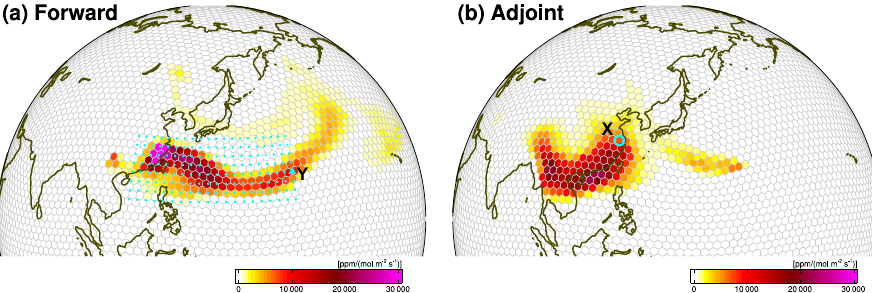
Figure 5. The concentration field at 3km altitude on 00:00UTC 8 January 2010 simulated by the forward model (with the flux limiter) from the basis unit flux X (a) and the sensitivities of the observation Y against the surface fluxes (footprint) simulated by the continuous adjoint model (b) . The observation points, from which the adjoint sensitivities are calculated, are denoted as cyan dots and the location of observation Y is indicated by the cyan triangle (a) . The location of the basis unit flux X is indicated by the open cyan circle (b) .